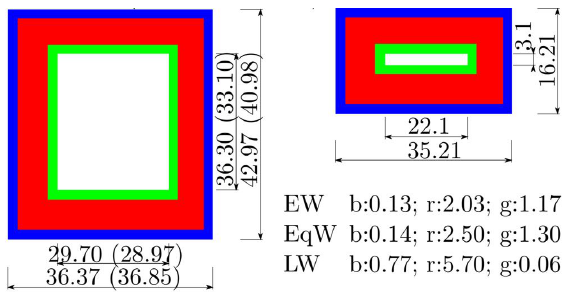
Figure 4. Periodic unit cells of earlywood, latewood, and equivalent